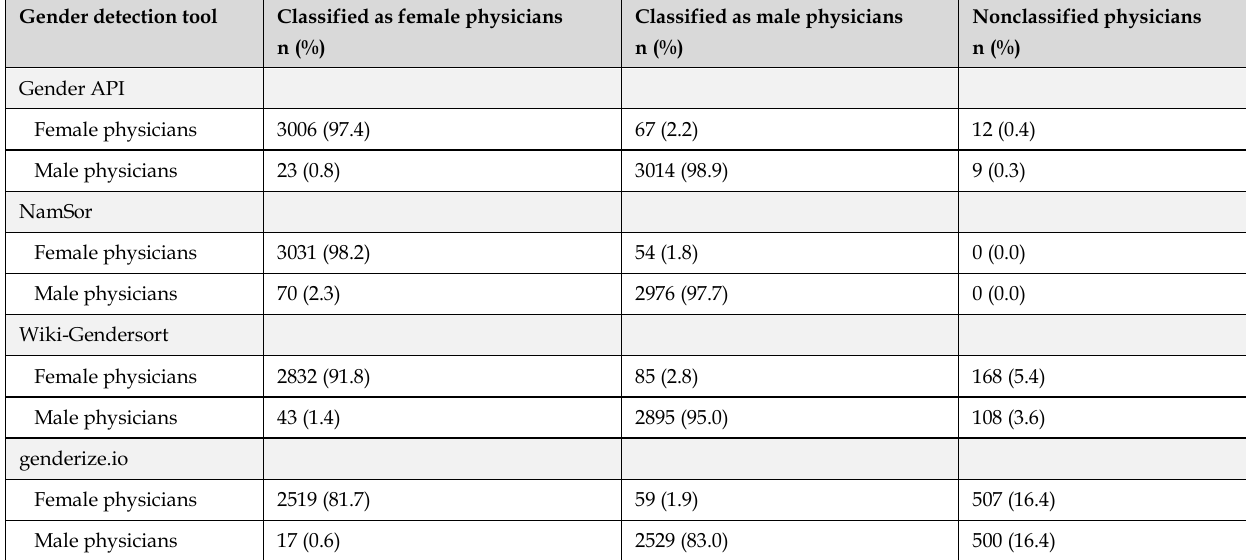
Table 2 Confusion matrices for gender detection tools (n=6,131 physicians) Gender detection tool